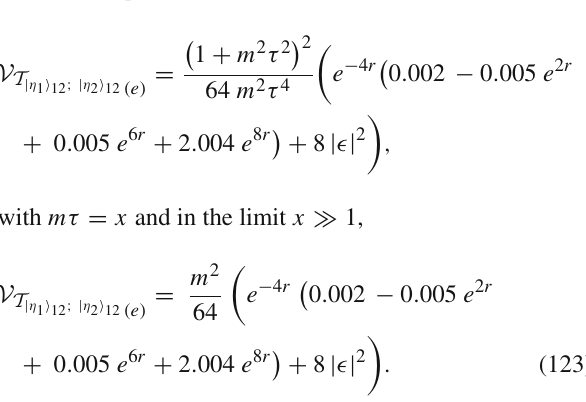
(cid:3) | η (cid:3) 1 12 and 2 12 states are